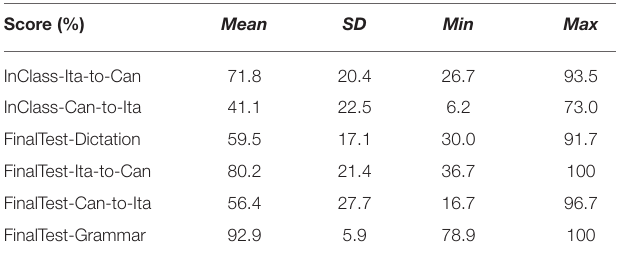
TABLE 2 | Summary statistics of the scores for the in-class quizzes (Ita-to-Can and Can-to-Ita) and the final